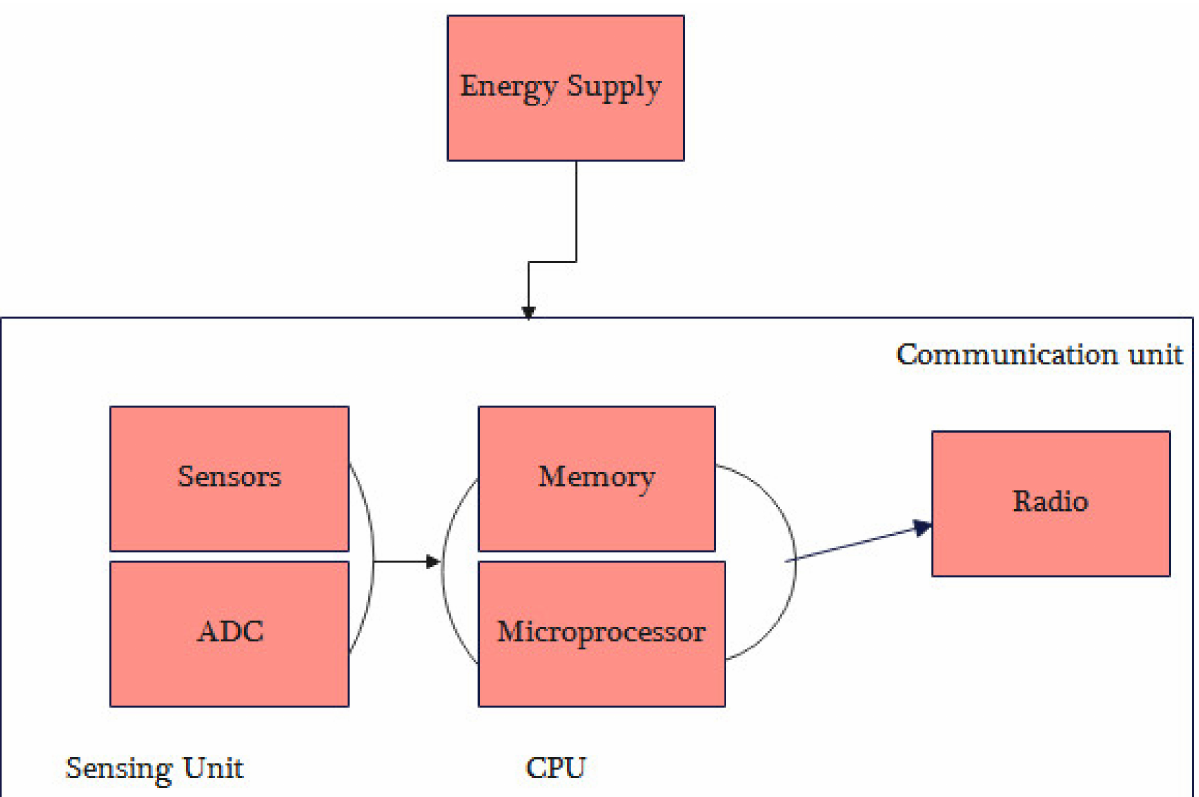
Figure 5. The architecture of a sensing unit for smart buildings